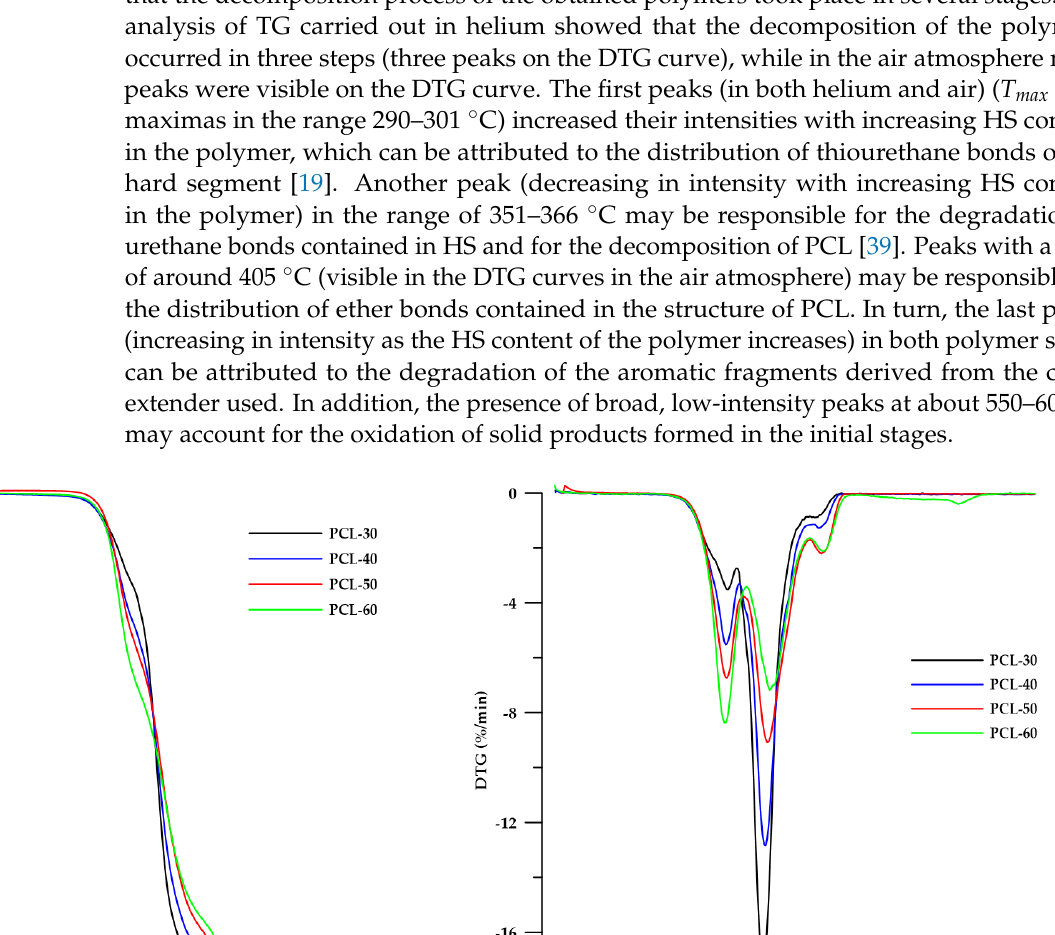
( b ) Figure 8. TG ( a ) and DTG ( b ) curves of the obtained polymers (in air). 3.3.3. DMTA To investigate the influence of the soft segments rather than the viscoelastic proper ‐ ties of SPTURs, dynamic mechanical thermal analysis was performed. Changes of storage modulus ( E ′ ), loss modulus ( E ″ ) and mechanical loss factor (tan δ ) with temperature are shown in Figure 9, while DMTA data are summarized in Table 5. Due to the fact that the PCL ‐ 30 sample shows partial ordering resulting from crystal ‐ lization of the soft segment, an analysis of the sample being in amorphous form was ad ‐ ditionally performed. For this purpose, the compressed sample section was heated in an